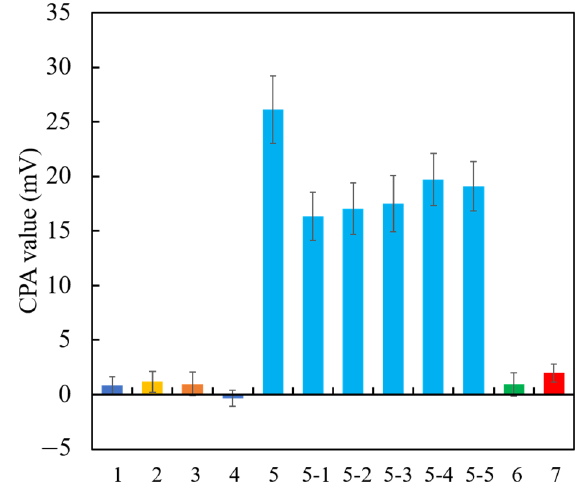
Figure 13. The CPA values for different taste qualities. (1) Saltiness sample (300 mM KCl); (2) sour- ness sample (3 mM tartaric acid); (3) umami sample (10 mM sodium glutamate); (4) astringency sample (0.05% tannic acid); (5) bitterness (+) sample (0.1 mM of hydrochloride salts of (5) quinine, (5-1) azelastine, (5-2) cetirizine, (5-3) loperamide, (5-4) eperisone, (5-5) hydroxyzine; (6) bitterness ( − ) (0.01 vol% iso-alpha acid); (7) sweetness sample (1 M sucrose). All taste samples were prepared with the reference solution.